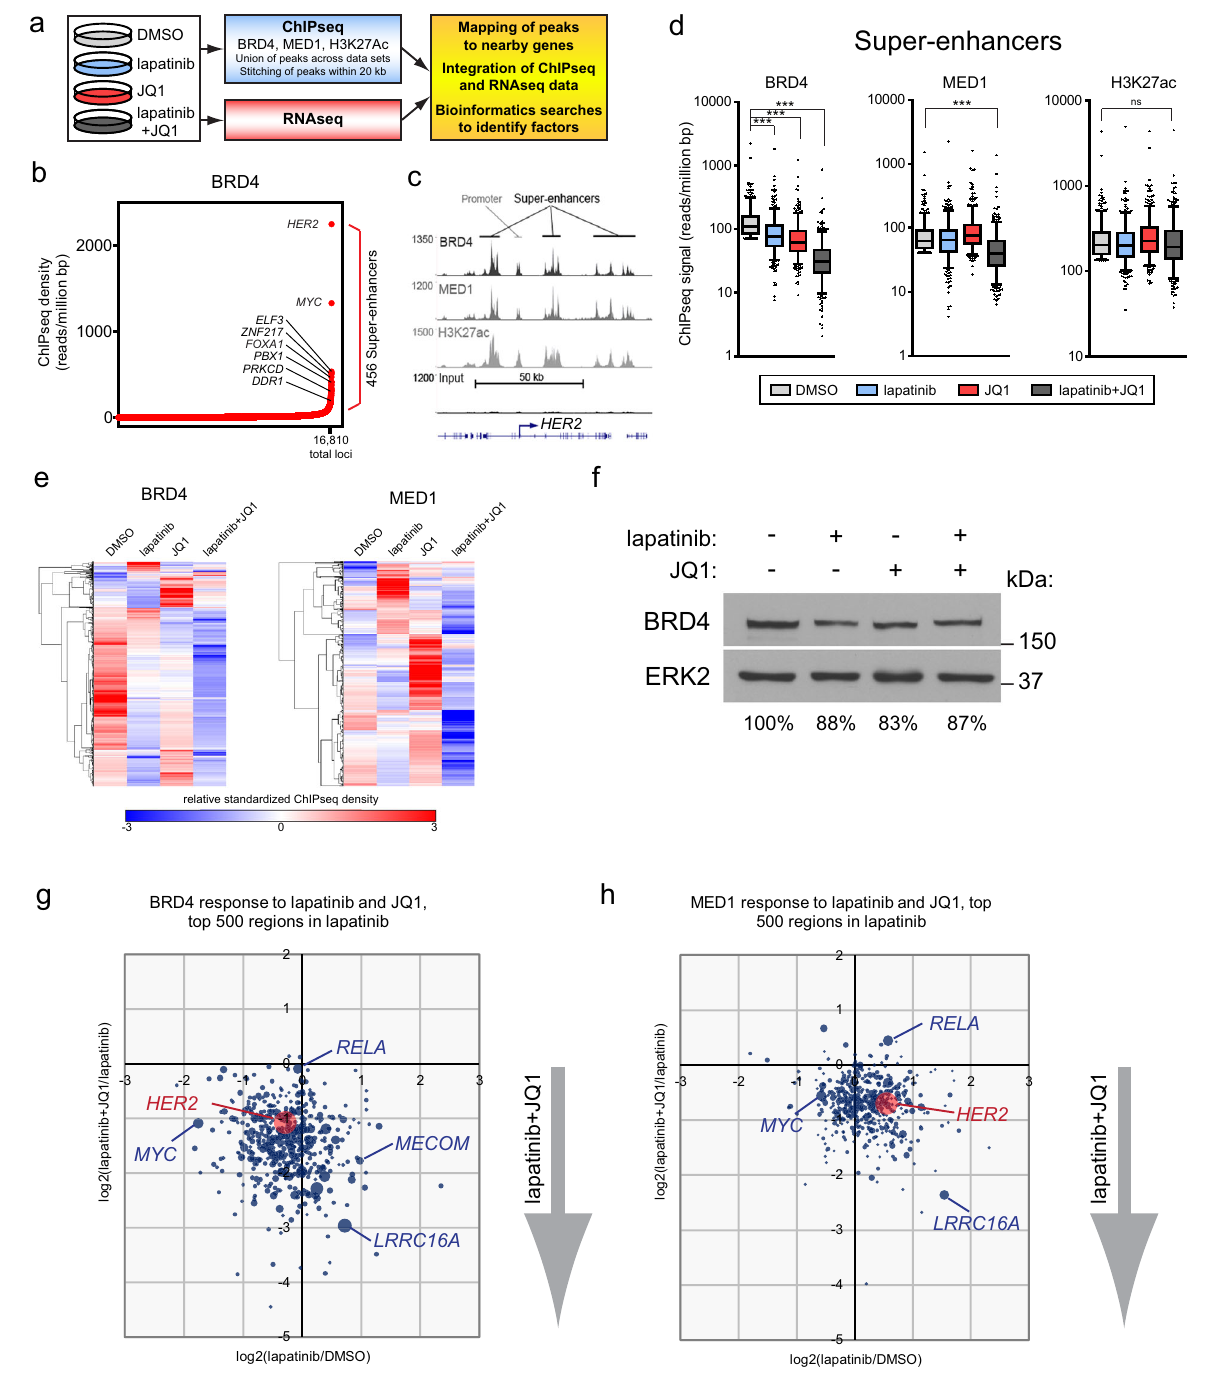
Fig. 1 Combined inhibition of HER2 and BET bromodomains induces broad epigenetic dysregulation. a Experimental strategy to identify epigenetic and transcriptional adaptive responses to HER2 inhibition in cell line models using 300 nM lapatinib and 300 nM JQ1 for 24 h, alone or in combination. b ChIPseq analysis of the HER2 + breast cancer cell line, SKBR-3, was performed to identify BRD4 binding sites. Super- enhancers (456 regions) were identi fi ed as regions above the in fl ection point of increasing BRD4 ChIPseq density. c Multiple SEs identi fi ed by high density of BRD4, MED1, and H3K27Ac are found fl anking the HER2 locus. d BRD4 and MED1 binding to SE domains is signi fi cantly reduced by the combination of lapatinib and JQ1, but H3K27Ac is unaffected. Box plots: median, upper/lower quartile, and 5 – 95 percentile. Unpaired t -test, *** = P < 0.0001. e Unsupervised hierarchical clustering of all genomic loci bound by BRD4 and MED1. Lapatinib and JQ1 each increase BRD4 and MED1 binding to discrete regions but the combination of drugs results in a loss of binding at the majority of loci. f Total protein levels of BRD4 are largely unaffected by lapatinib and JQ1 as determined by immunoblotting of treated SKBR-3 cells. ERK2 was used as a loading control. g , h The combination of lapatinib and JQ1 cooperatively reduce BRD4 and MED1 binding to HER2 and MYC . The top 500 regions of highest ChIPseq density in response to lapatinib are shown for g BRD4 and h MED1. The log 2 fold change in density in response to lapatinib vs. DMSO is plotted on the x -axis. The log 2 fold change of lapatatinib + JQ1 vs. lapatinib alone is plotted on the y -axis. Dot size is relative to ChIP density in